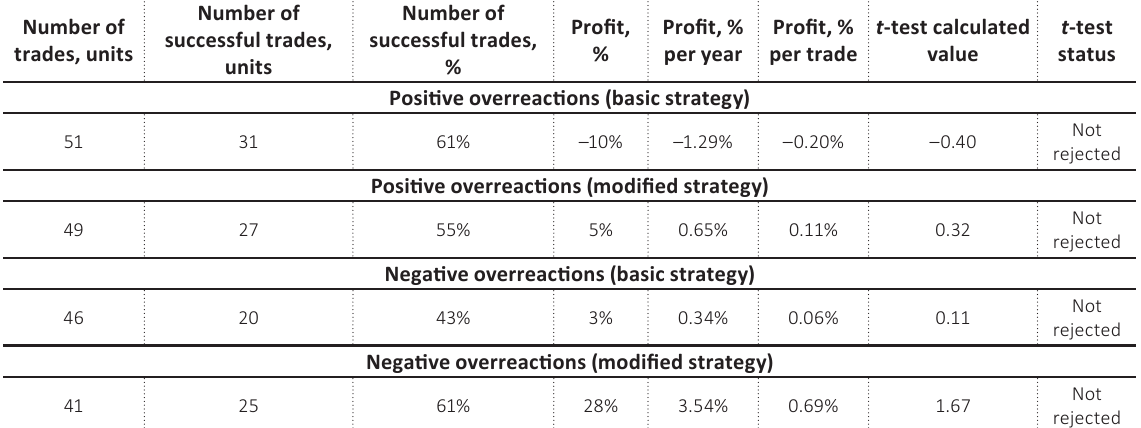
Table 8. Trading simulation results for the day after the overreaction: case of the Contrarian